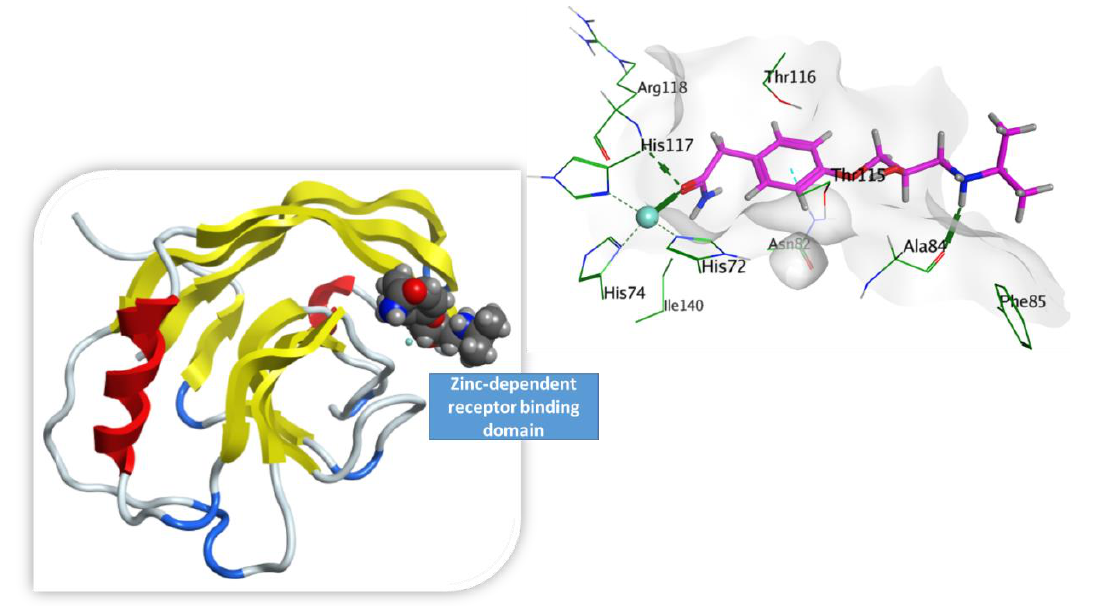
Figure 4. 3D binding of Atenolol (Purple) with MrpH active site showing the key amino acid interactions along with the crucial Zn +2 binding (Turquoise).